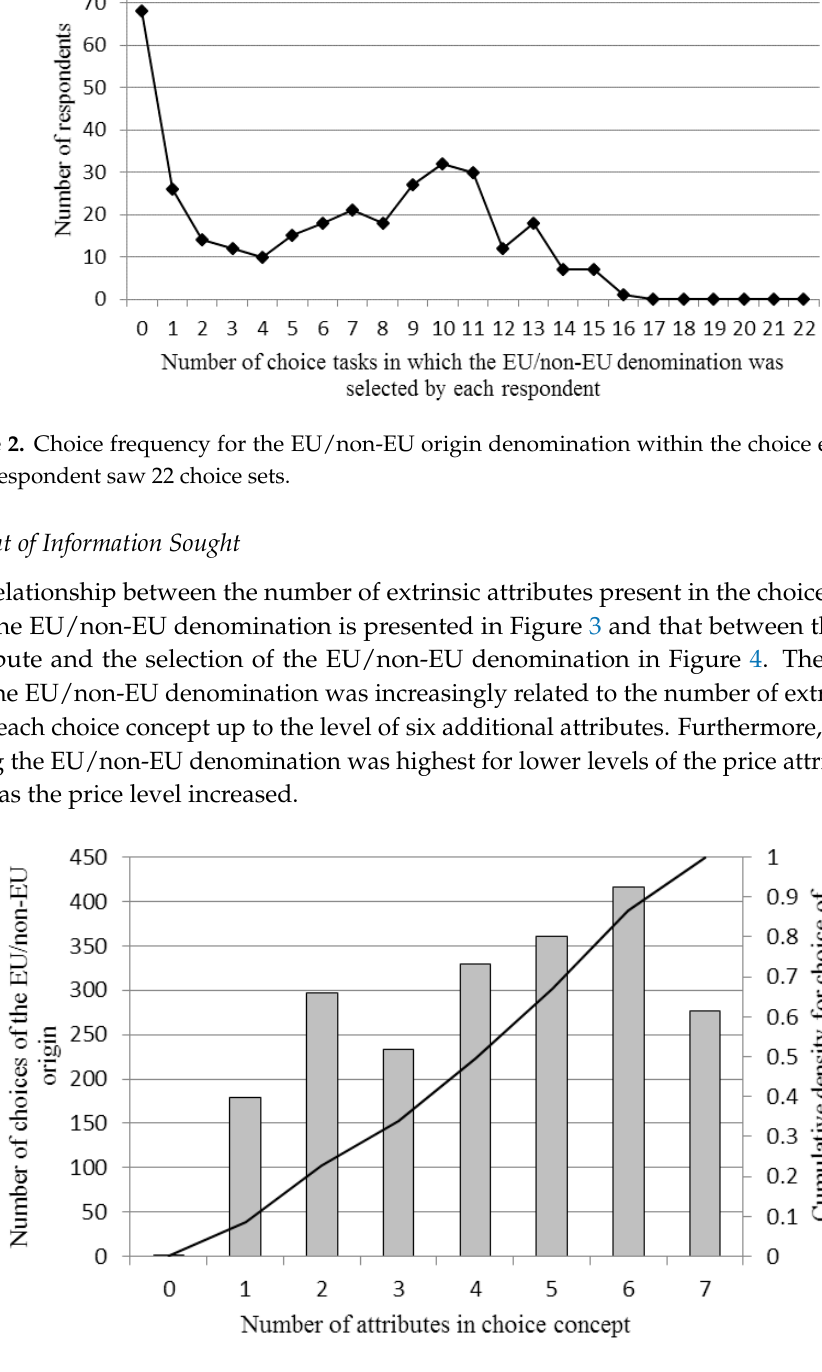
Figure 3. Histogram and cumulative density function for the number of choices of the EU/non-EU origin alternative by the number of extrinsic attributes in the choice experiment.